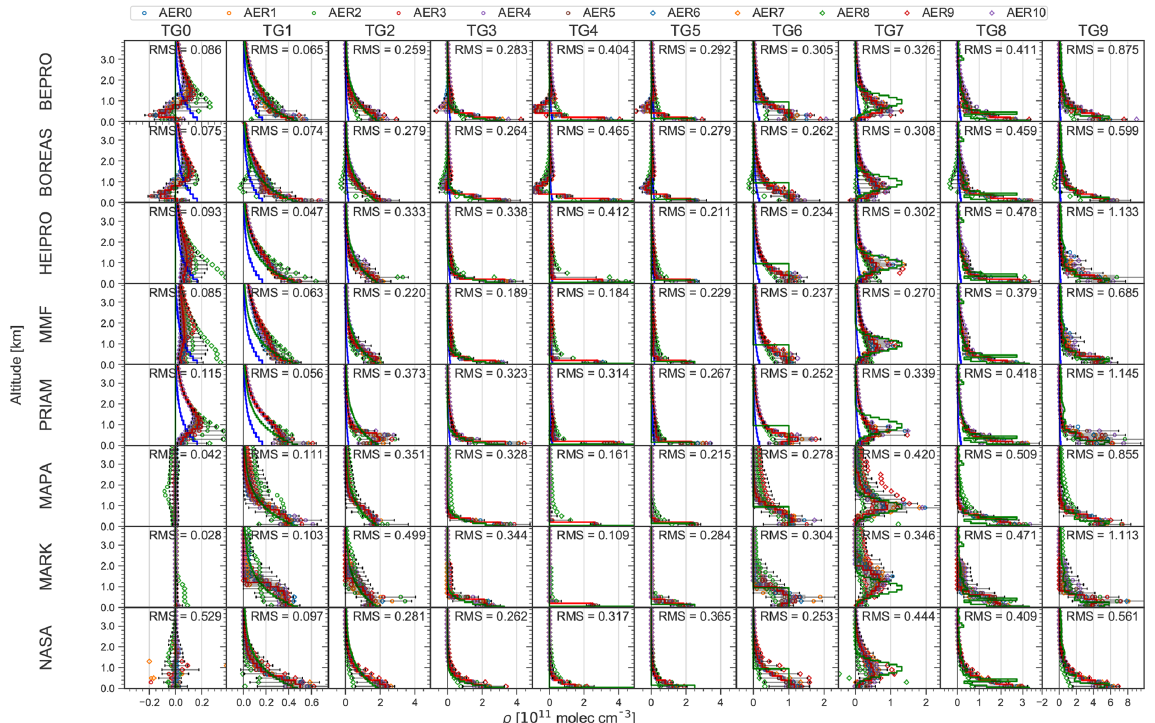
Figure 13. Comparison of retrieved (red solid line, version v1n) and true (green solid line) vertical profiles of HCHO for each trace gas scenario (columns) and algorithm (rows). In addition to the median profiles for all aerosol scenarios, SZAs and SAAs shown in red, the median concentration profile for each aerosol scenario is shown as coloured symbols as denoted in the legend. The RMS (true – retrieved extinction) is shown in units of 10 11 moleccm − 3